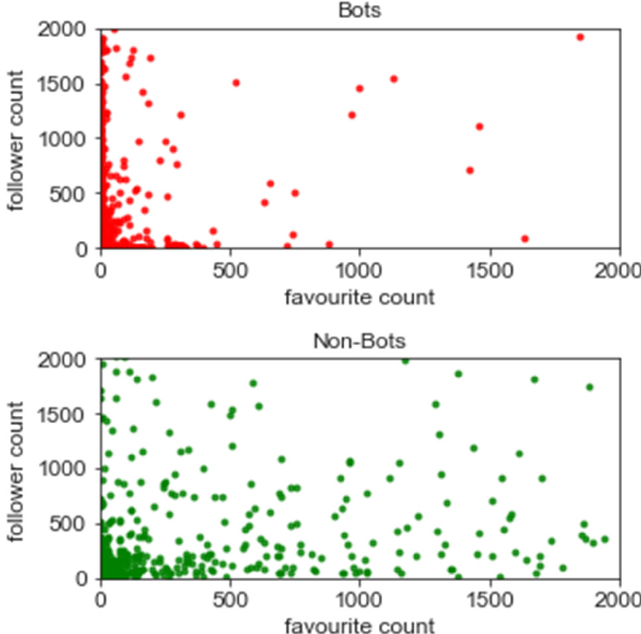
Figure 7. Follower against Favorites count for Bots and Non-bots .